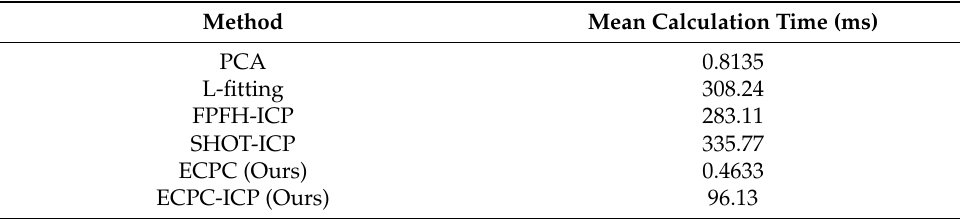
Figure 12. The calculation time distribution of all methods. Table 3. The mean calculation time of all methods.